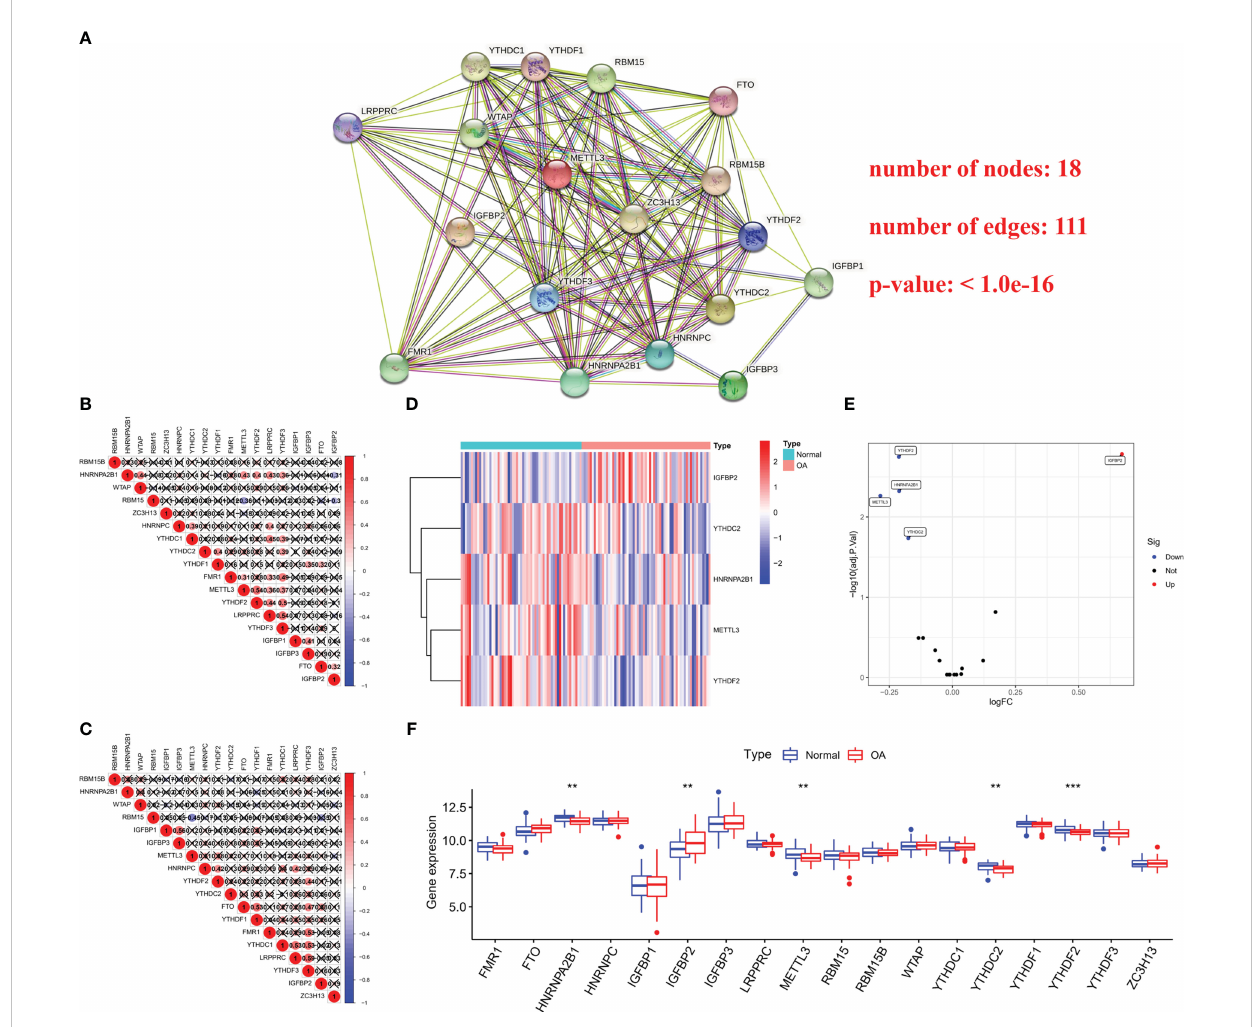
FIGURE 1 Expression landscape of m6A regulators in OA and healthy samples. (A) The protein-protein interaction (PPI) network of 18 m6A regulators. (B) Connection analysis between 18 m6A regulators expression in all samples. (C) Connection analysis between 18 m6A regulators expression in OA samples. (D, E) Heat map and volcano map of differences in hub m6A regulators expression between health and OA patients. (F) Box plot showing 18 m6A regulators expression in OA samples compared with the control. **p < 0.01, and ***p <